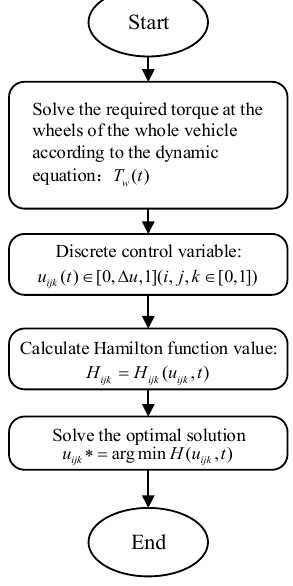
Figure 2. Solution flow of